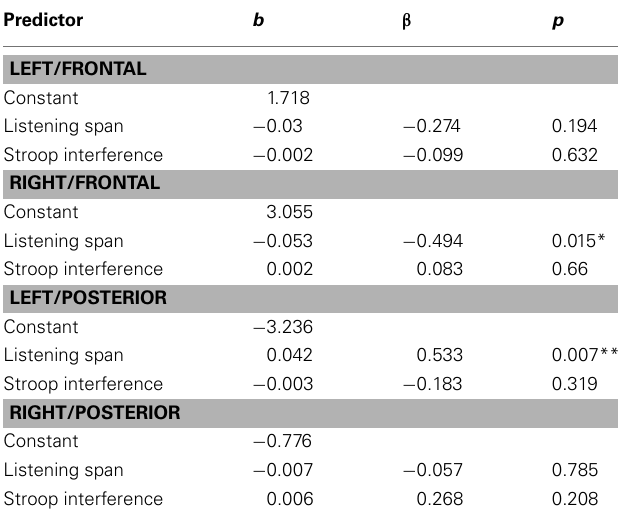
Table 5 | Multiple regression analysis of discourse congruence effect size (two predictors) showing unstandardized ( b ) and standardized ( β ) partial coefficients, and probability levels ( p ).